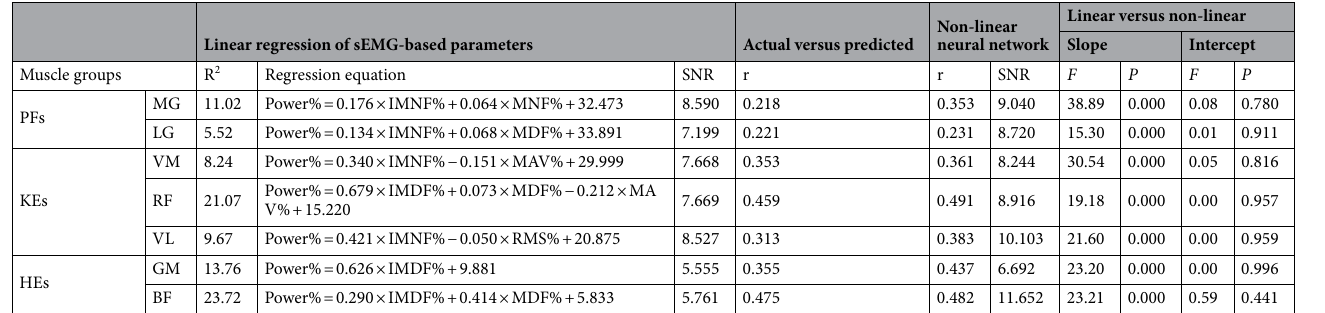
Table 2. The difference between linear regression and non-linear neural network for predicting the power loss. PFs plantar flexors, KEs knee extensors, HEs hip extensors. MG medial gastrocnemius, LG lateral gastrocnemius, VM vastus medialis, RF rectus femoris, VL vastus lateralis, GM gluteus maximus, BF biceps femoris. r pearson’s correlation coefficients, R 2 coefficient of determination, SNR signal-to-noise ratio. RMS root mean square, MAV mean absolute value, MNF mean frequency, MDF median frequency, IMNF instantaneous mean frequency, IMDF instantaneous median frequency. Changes in percentage of